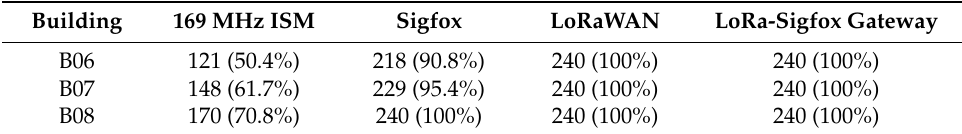
Table 2. Reception rates over a period of 10 days (240 samples) with each of the different systems tested in a water-meter with a percentage of received samples ranged within 25%–75% over expected in the 169 MHz ISM band.